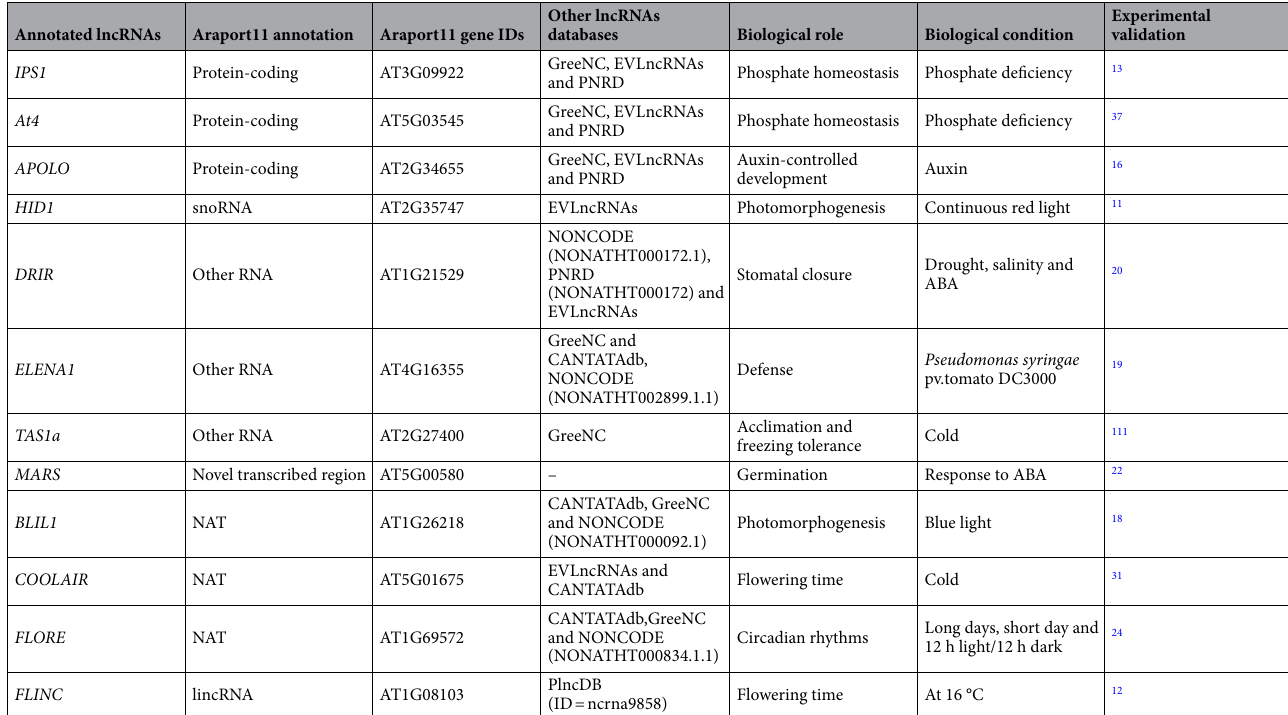
Table 2. Example lncRNAs annotated in